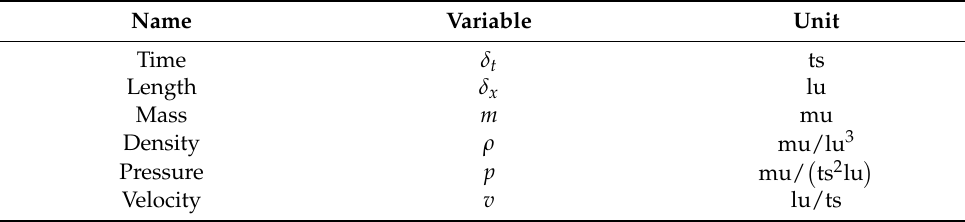
Table 1. Basic physical quantity